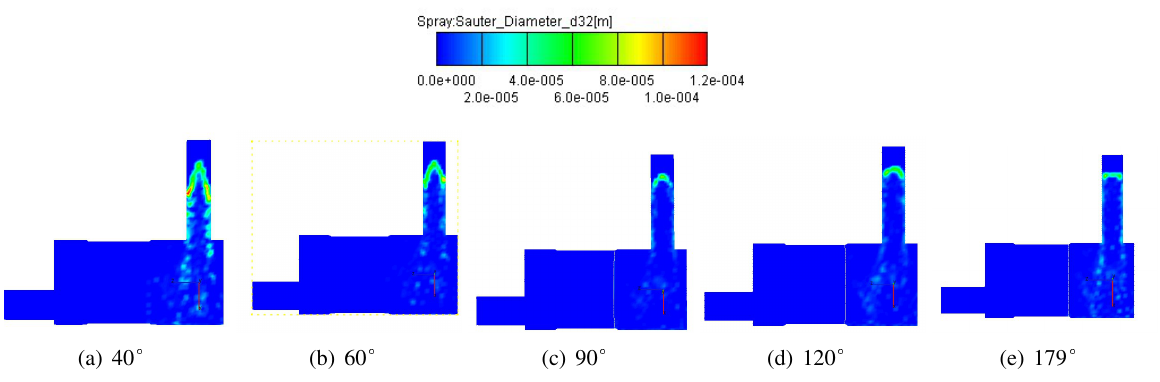
Fig. 6 Particle distribution at different injection angles (Y